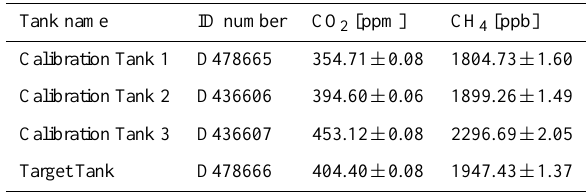
Table 2. Comparison of flask data with deconvolved CRDS